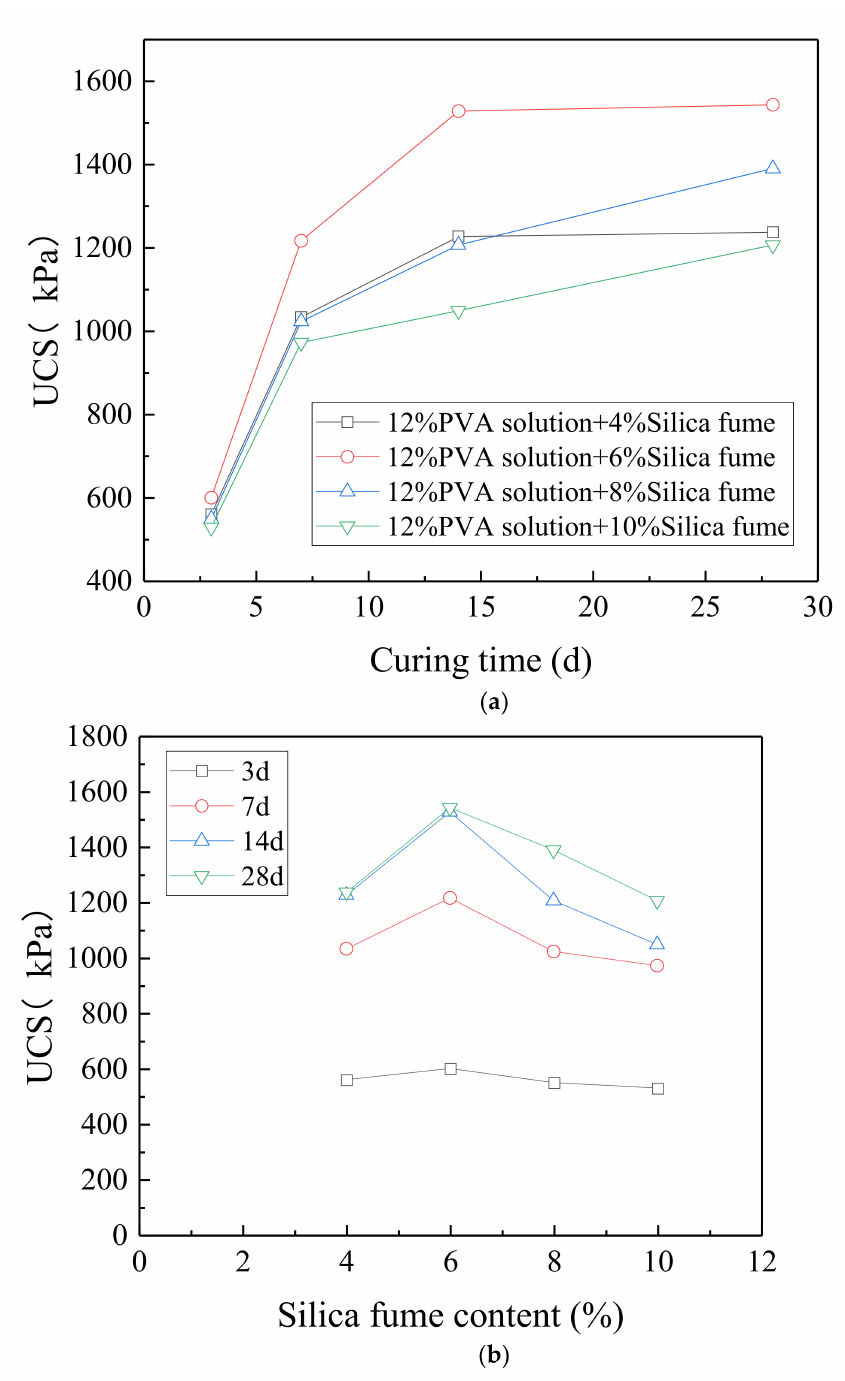
Figure 7. Relationship between ( a ) curing time, ( b ) silica fume content, and UCS of stabilized